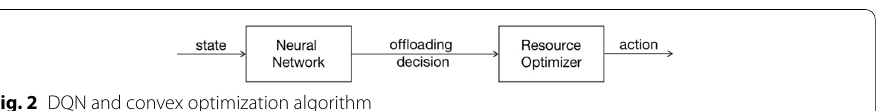
Fig. 2 DQN and convex optimization